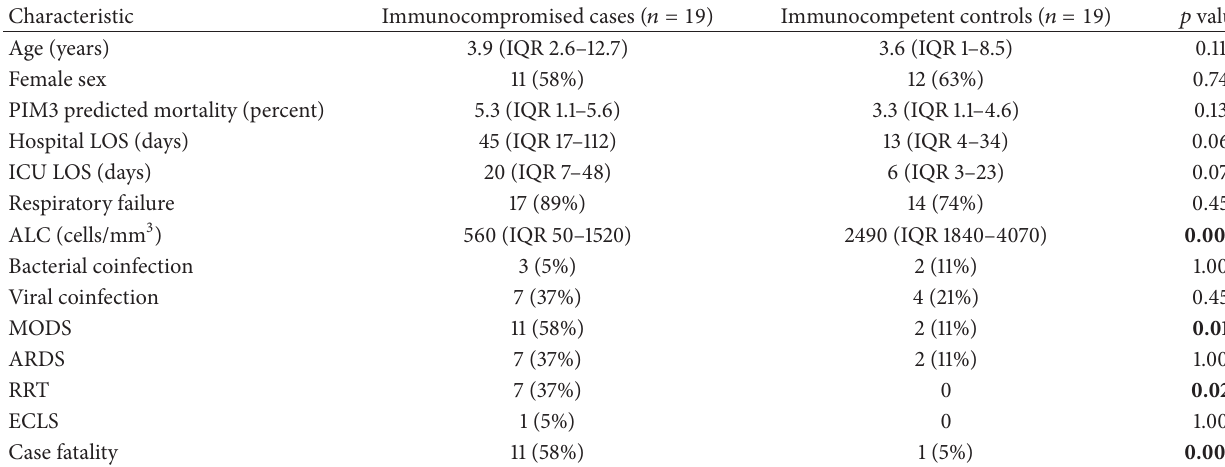
Table 4: Matched case control analysis of immunocompromised cases with severe adenoviral respiratory infection and immunocompetent controls with severe adenoviral respiratory